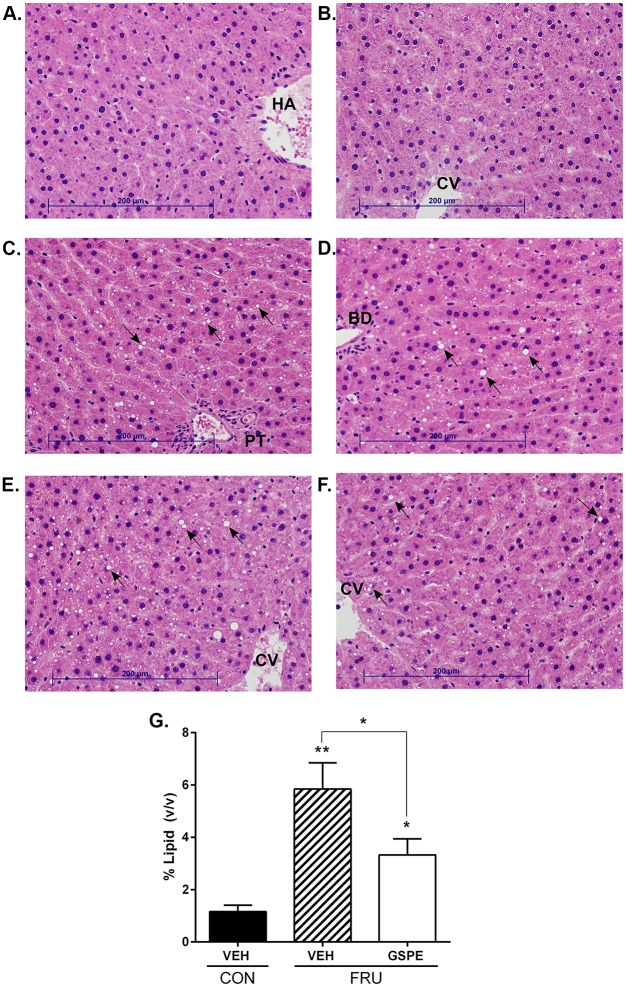
Fructose-induced hepatic lipid accumulation is ameliorated by GSPE administration.Representative liver histology sections stained with hematoxylin and eosin from (A and B) Control, (C and D) Fructose-vehicle and (E and F) Fructose-GSPE treated rats. Lipid droplet infiltration is evident in the fructose-fed rats as indicated by the black arrows (BD: Bile duct; CV: Central vein; HA: Hepatic artery; PT: Portal triad); (G) Lipid accumulation induced by fructose consumption was evaluated using image analysis of the histological sections from each animal. The volume of lipid droplets was assessed as a percentage of the total hepatic volume. *p<0.05 and **p<0.01.